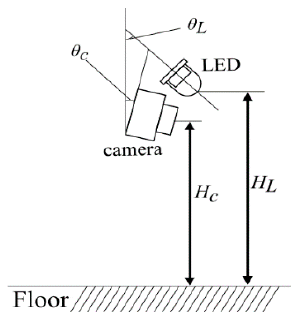
Figure 14. Position relationship between the camera and the LED attached to the robot.